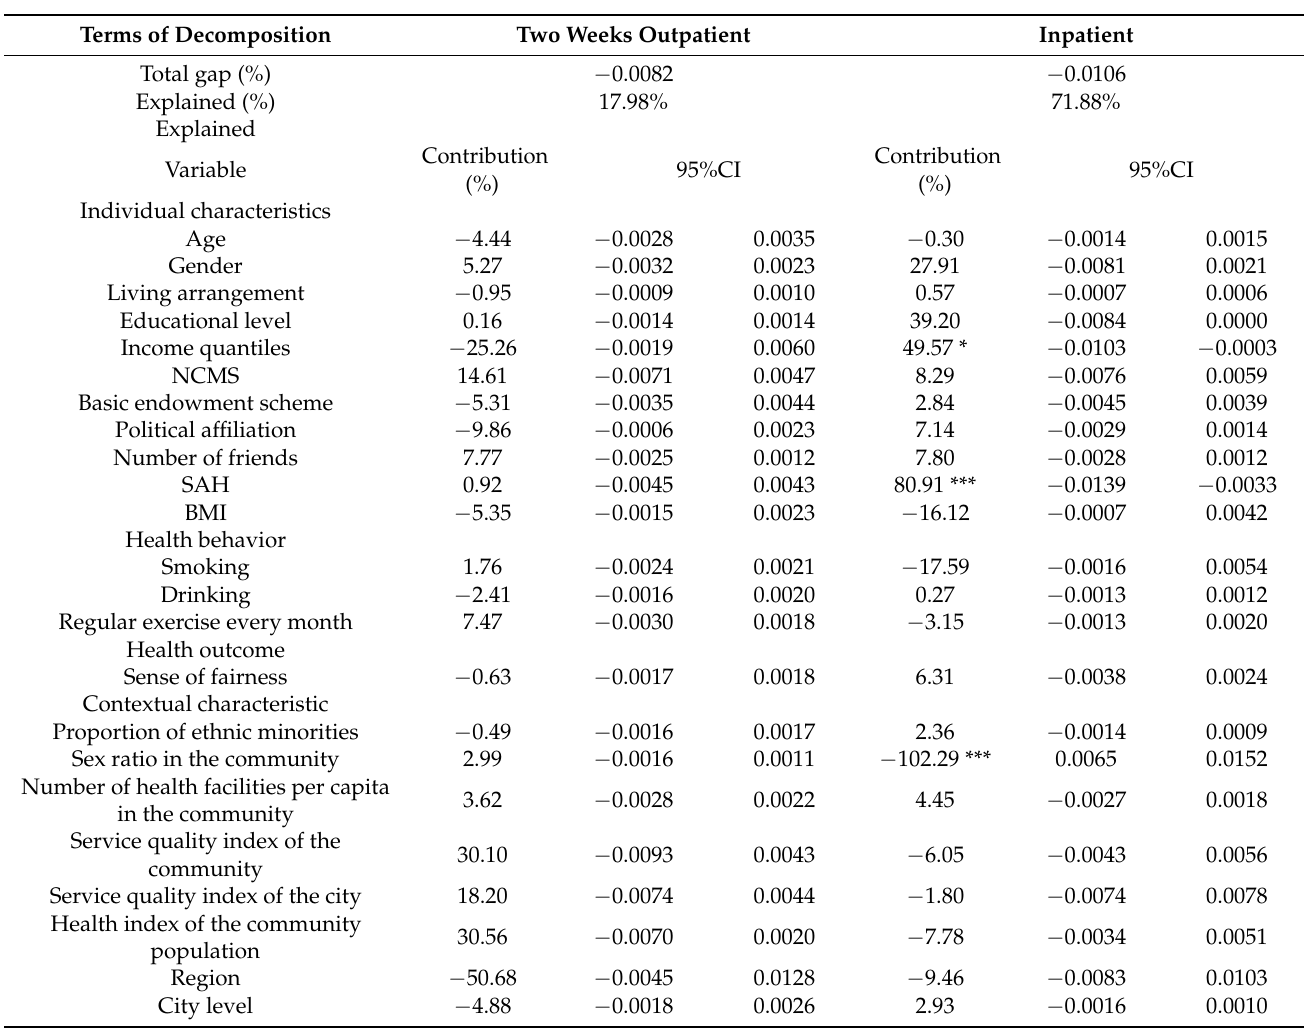
Table 3. Fairlie’s decomposition of the difference of health service utilization between matched older rural-to-urban migrant workers and older rural